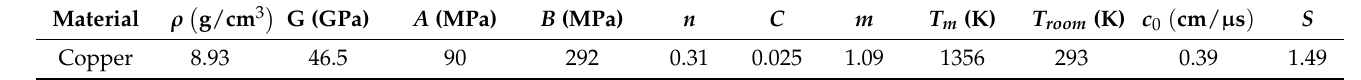
Table 3. Material parameters for liner.